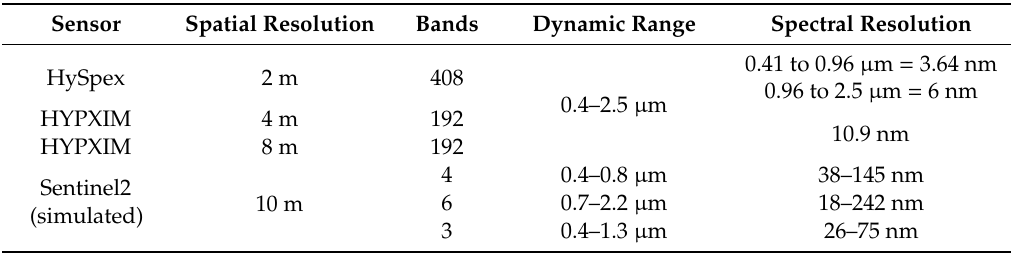
Table 2. Spectral and spatial characteristic of images